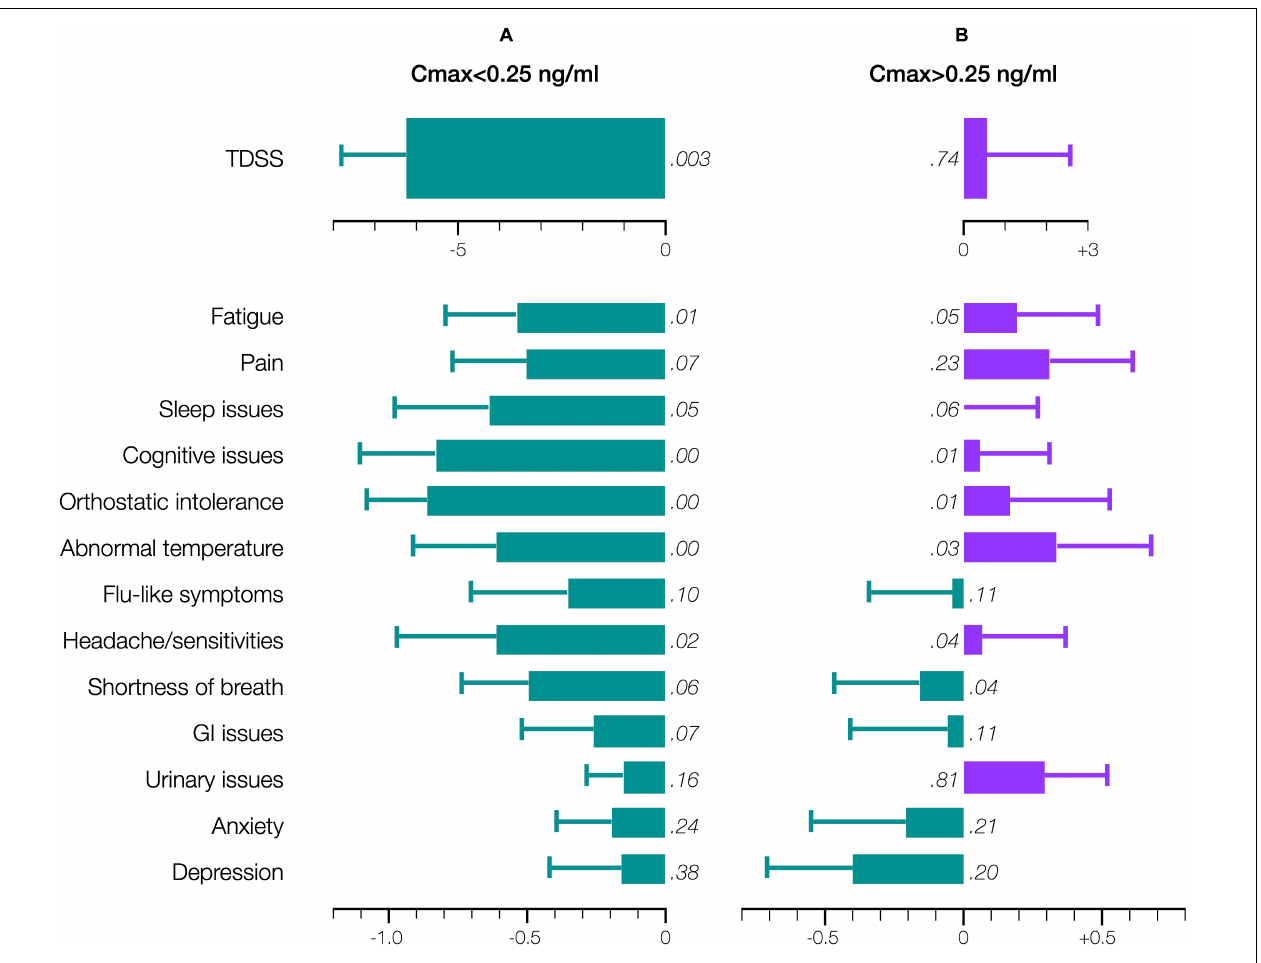
FIGURE 6 | Effect of CT38 on the pre-/post-treatment change in the 28-day means (bars), with standard deviations (error bars), of TDSS and individual symptoms scores, for CT38: (A) Cmax < 0.25 ng/ml; or (B) Cmax > 0.25 ng/ml, either improving (green) or worsening (purple) with relevant p -values (in italics). Note that scales for TDSS and individual symptoms are